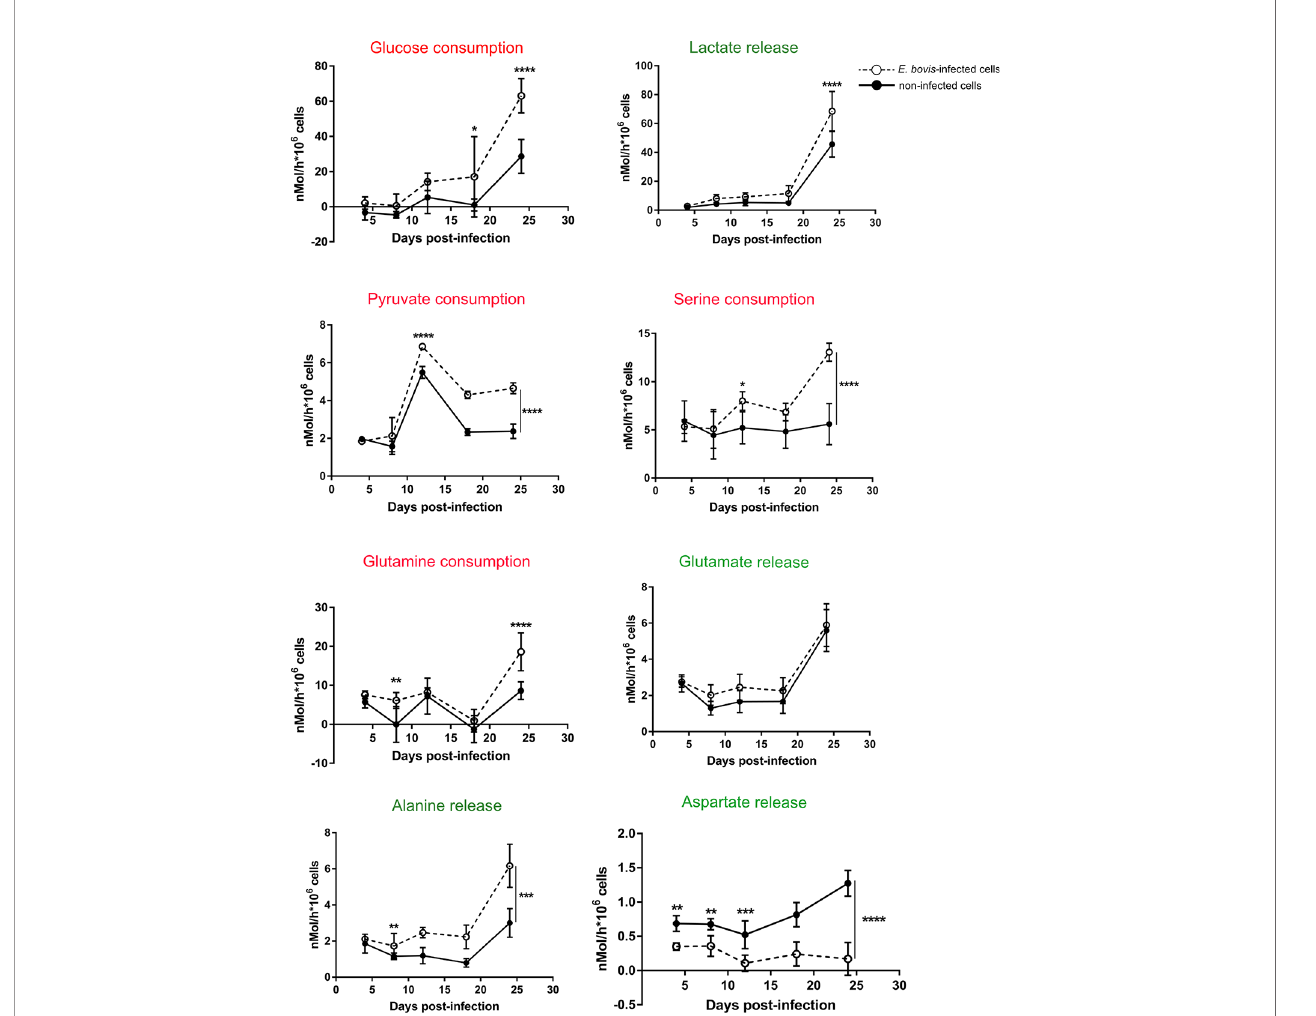
FIGURE 2 | E. bovis infection modulates metabolic responses in host endothelial cells. The metabolic signatures of non-infected and E. bovis – infected BUVEC were measured at 4 h p. i., 4, 8, 12, 18, and 24 days p. i. The concentration of several key molecules related to glucose metabolism as well as glutaminolysis, another important source of energy and cell building blocks were determined in supernatants of non-infected and E. bovis – infected cells at each time point. The metabolite conversion rates were normalized by the total number of cells present in the cell layer at each condition. The results are represented as nMol/h per 1 x10 6 cells of each metabolite, in E. bovis – infected ( ◌ ) and non-infected cells ( (cid:129) ) at the indicated days p. i. Statistical analysis applied was a two-way ANOVA with repeated measurements de fi ning the time as the matching variable (signi fi cance de fi ned as a ≤ 0.05). Values are expressed as means ± SD of three biological replicates. *p = 0.05, ** p ≤ 0.01, *** p ≤ 0.001, **** p ≤